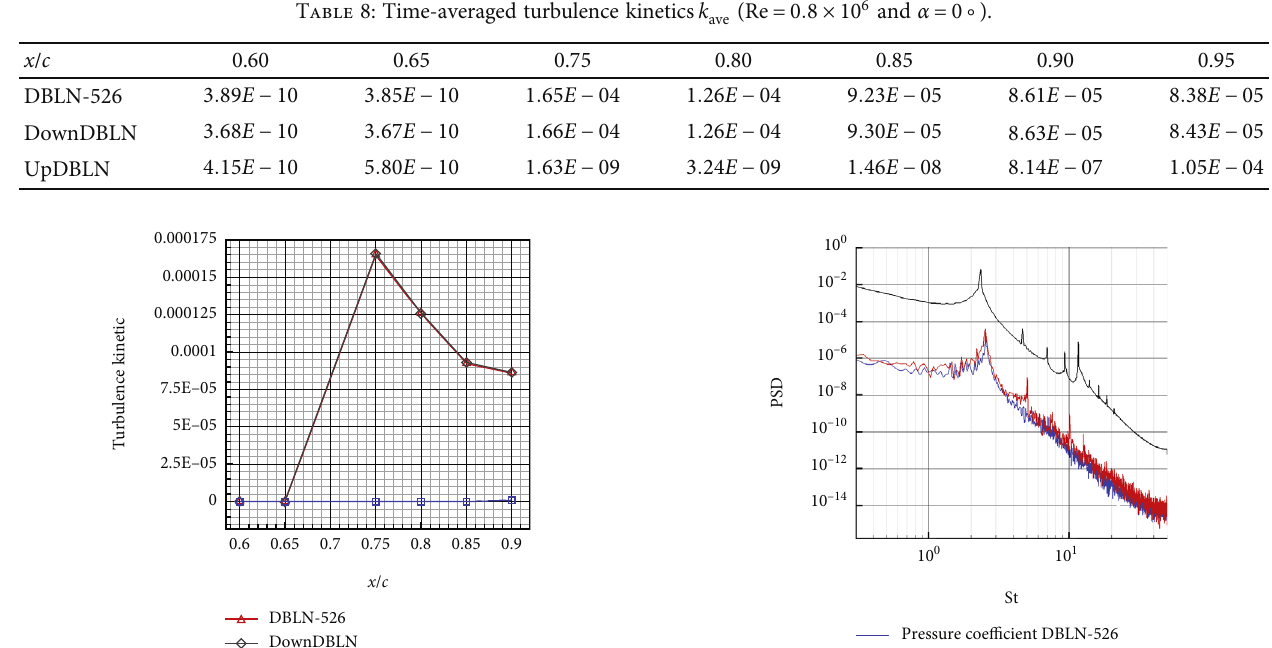
Table 8: Time-averaged turbulence kinetics k